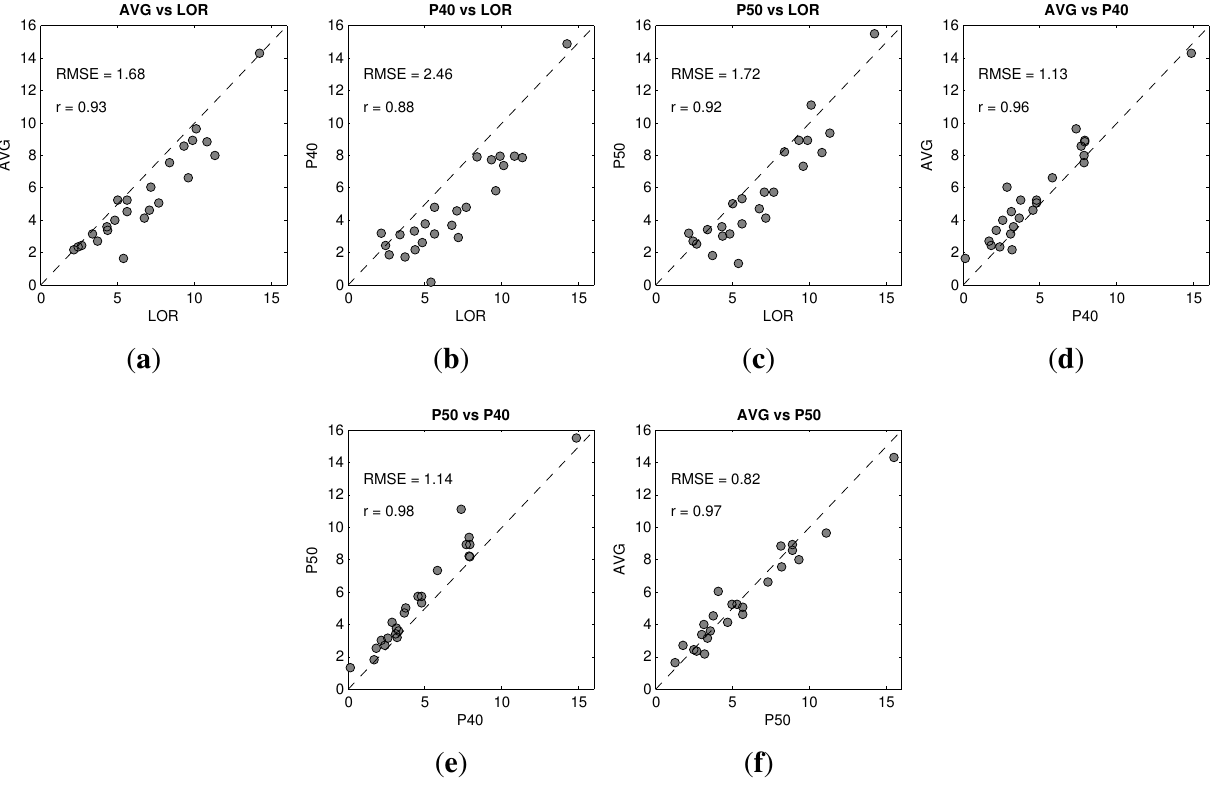
Figure 14. Comparison of the four dependent variables used in estimating CBH: ( a ) LOR vs. AVG; ( b ) LOR vs. P40; ( c ) LOR vs. P50; ( d ) P40 vs. AVG; ( e ) P40 vs. P50; ( f ) P50 vs. AVG. r represents the coefficient of correlation between the